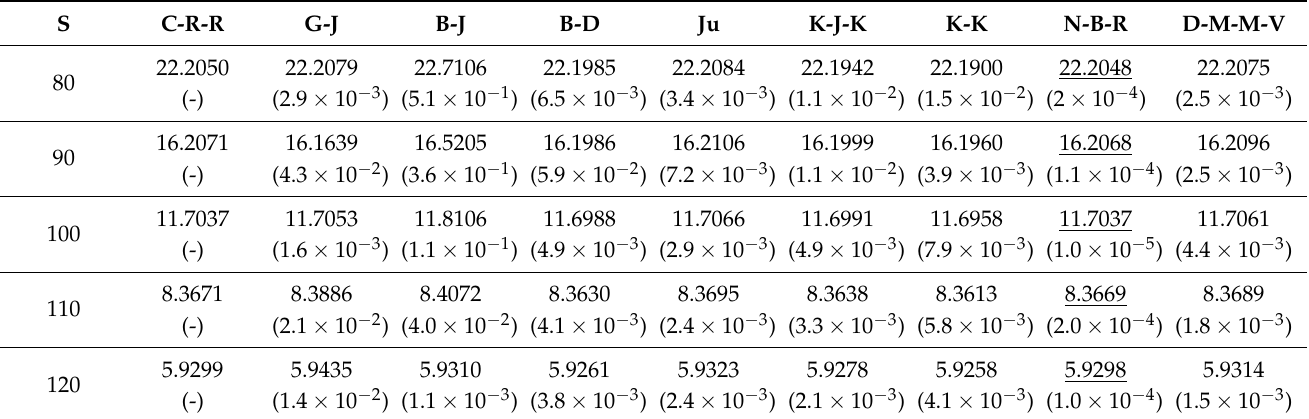
Table 1. Numerical approximations of American put price: S as in the first column, T = 3, σ = 0.2, r = 0.08, K = 100, δ = 0.08, and n = 32. For each value of S , the resulting approximation errors are displayed in the second rows within brackets. Some data in Table 1 were extracted from [22]; in addition, underlined values represent approximated prices to which the lowest error corresponds.